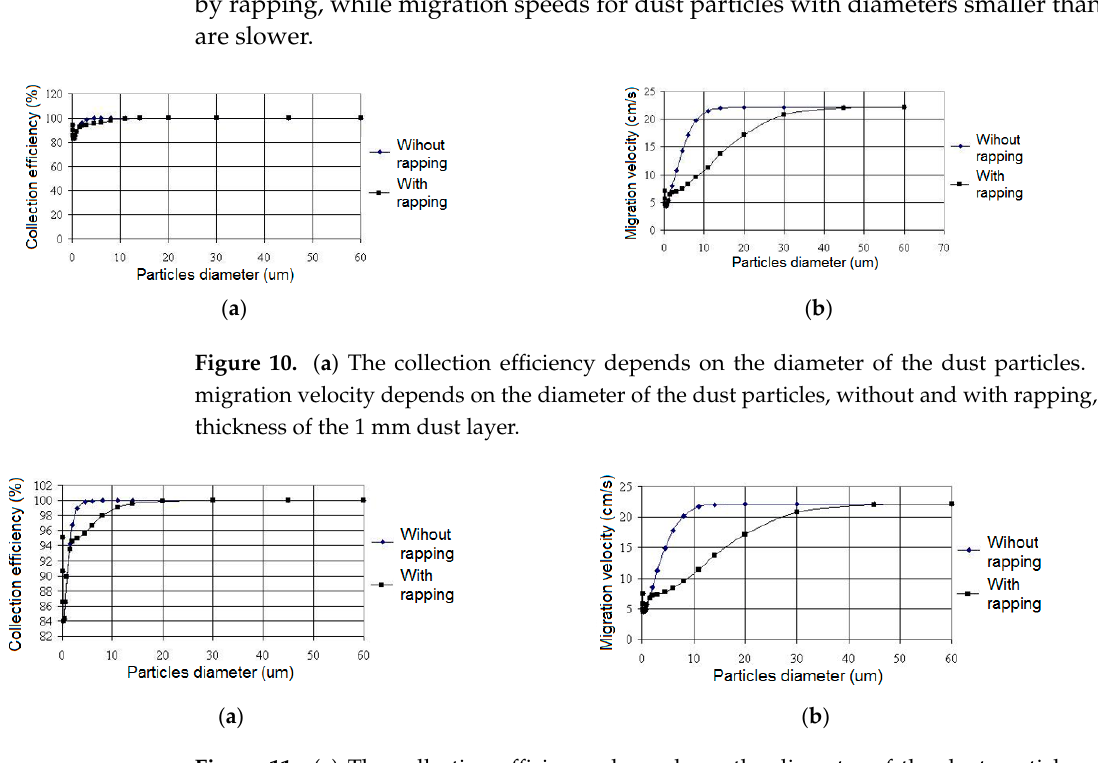
value in each individual section (Tables 10 and 11). A larger layer of dust on the collector surfaces emphasizes the ESP’s growing improvement in collection, with collection effi ‐ ciency slightly increasing. When the electrodes are constantly rapping, the collection effi ‐ ciency drops by about 1.1% compared to when the sections are not rapping (due to the dust re ‐ entrainment phenomenon). The dust concentration at the outlet of ESPs that treat flows of hundreds of thousands of m 3 /h of gas (Table 1) appears to be low. The density of dust emissions is reduced as dust layers thicken. The low dust emission density suggests smaller and smaller dust particles. The dust emission density is lower when the electrodes are not disturbed as much as when they are.